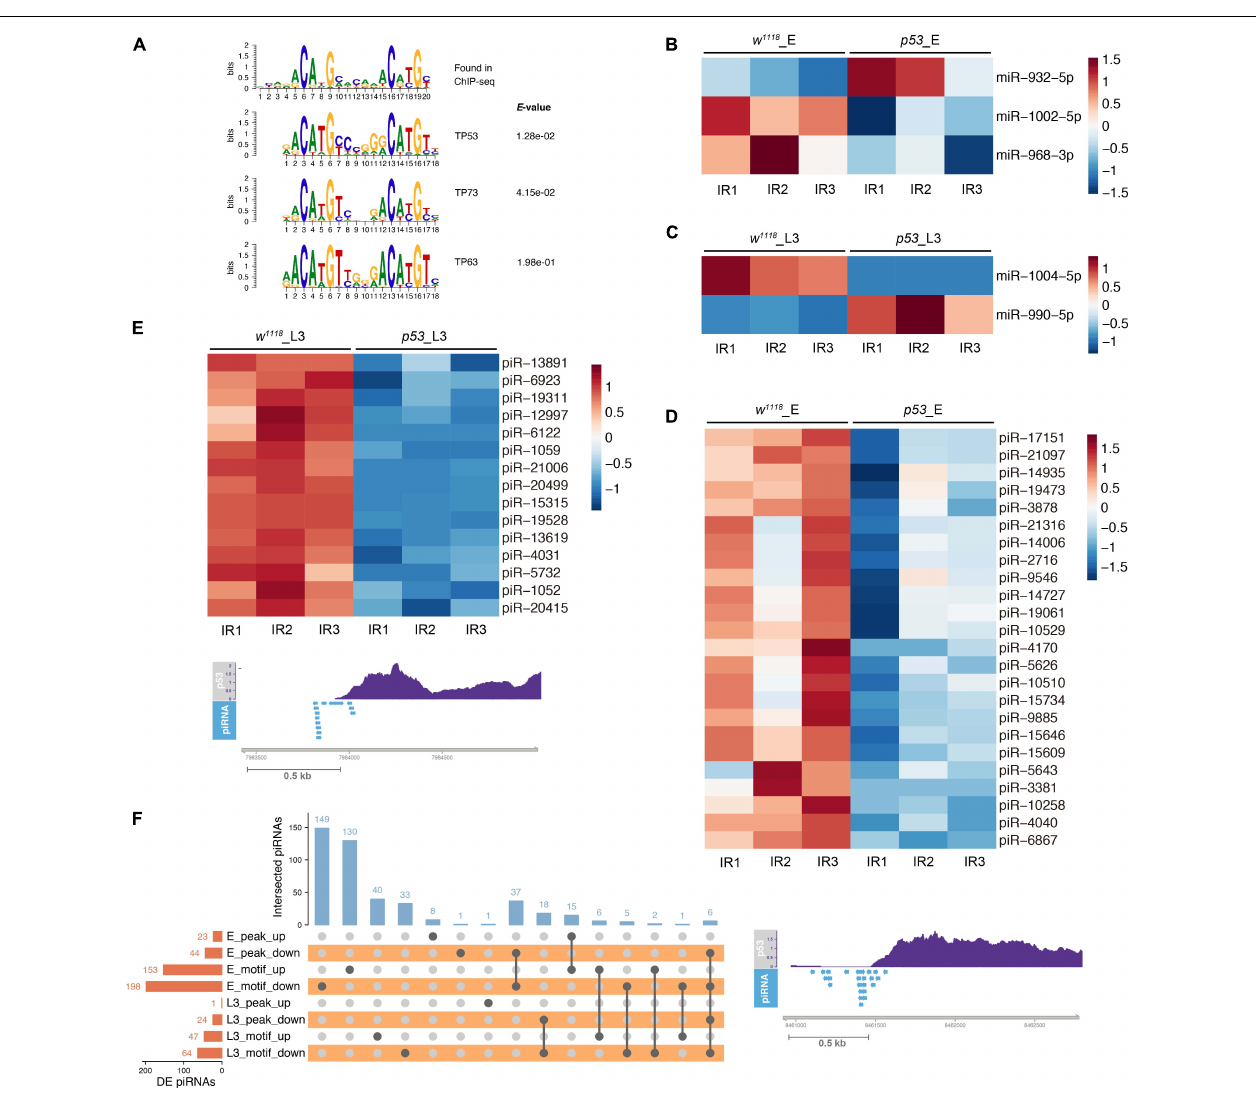
FIGURE 8 | p53 regulated small ncRNAs in response to X-ray irradiation. (A) p53 consensus motif derived from MEME de novo motif analysis. (B) Heatmap of DE miRNAs in p53 mutant embryos containing p53 binding-motif. (C) Heatmap of DE miRNAs in p53 mutant L3 containing p53 binding-motif. (D) Representative illustration of DE piRNAs in p53 mutant embryos (D) and L3 (E) containing p53 binding-peak. (F) UpSet plot depicting the number of DE piRNAs with p53 binding-peak and p53 binding-motif.